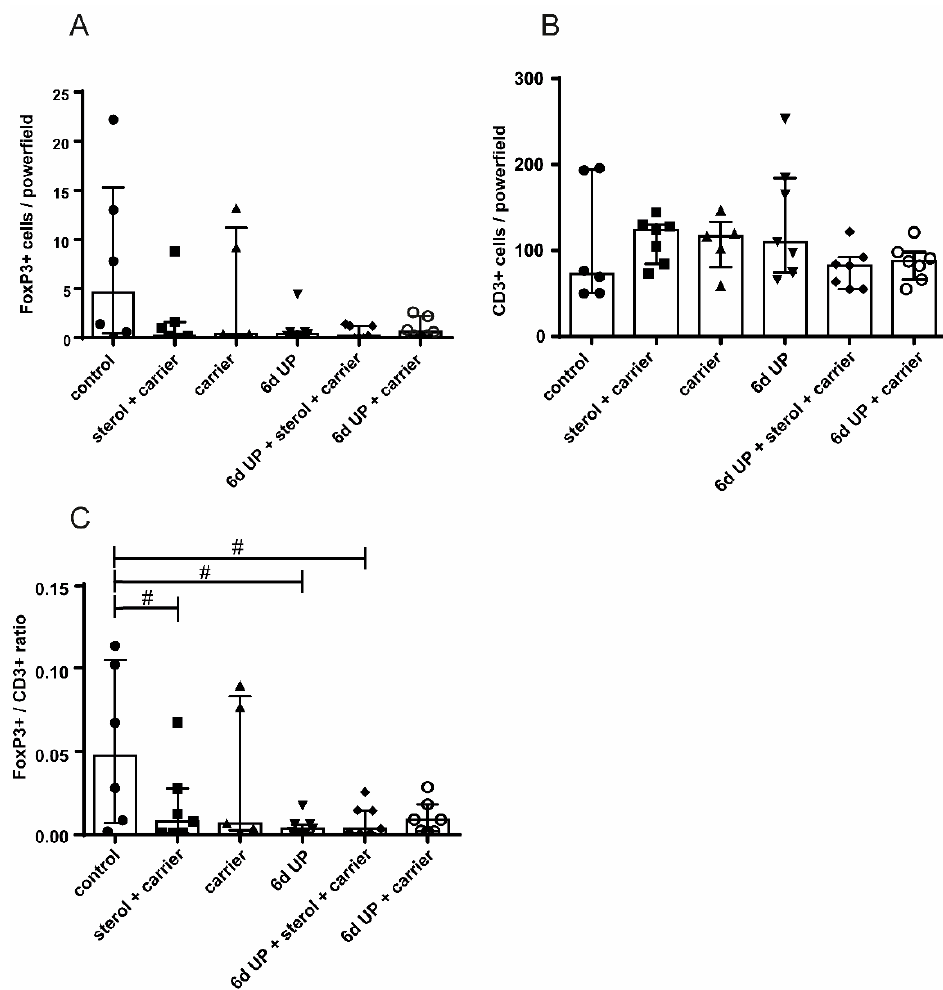
Figure 4. The number of CD3-positive cells, FoxP3-positive cells, and the FoxP3+/CD3+ ratio in the distal ileum of preterm lambs. ( A ) FoxP3-positive cells and ( B ) CD3-positive cells are displayed for all treatment groups. No significant differences were observed. ( C ) The FoxP3+/CD3+ ratio tended to be reduced in fetuses of the sterol + carrier, 6-d UP, and 6-d UP + sterol + carrier groups. The number of CD3+ and FoxP3+ cells were counted per high-power field, and the mean value of the count in five representative high-power fields is given. # 0.05 < p < 0.10. Abbreviations: CD3, cluster of differentiation 3; FoxP3, fork head box P3; UP, U. parvum .